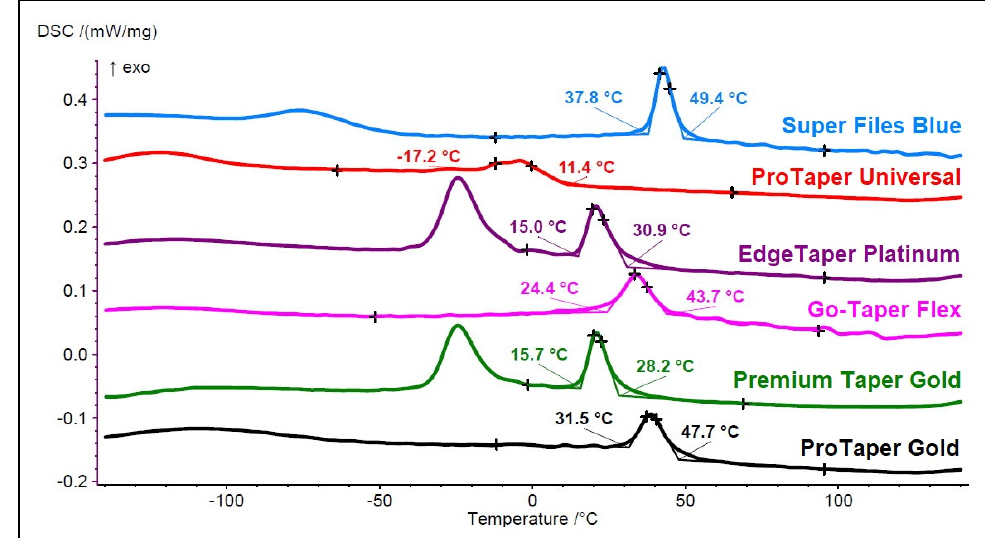
Figure 4. DSC chart shows the cooling curves of the ProTaper Gold (in black), Premium Taper Gold (in dark green), Go-Taper Flex (in pink), EdgeTaper Platinum (in purple), ProTaper Universal (in red), and Super Files Blue (in blue). The chart highlights the R-phase start (Rs) (on the right) and finish (Rf) (on the left) temperatures of each instrument. Overall, the DSC analysis showed differences in the phase transformation temperatures amongst the tested systems, with Rs temperature of heat-treated instruments above 28.2 °C. Table 3. Median (interquartile range) results of the mechanical tests and microhardness *.